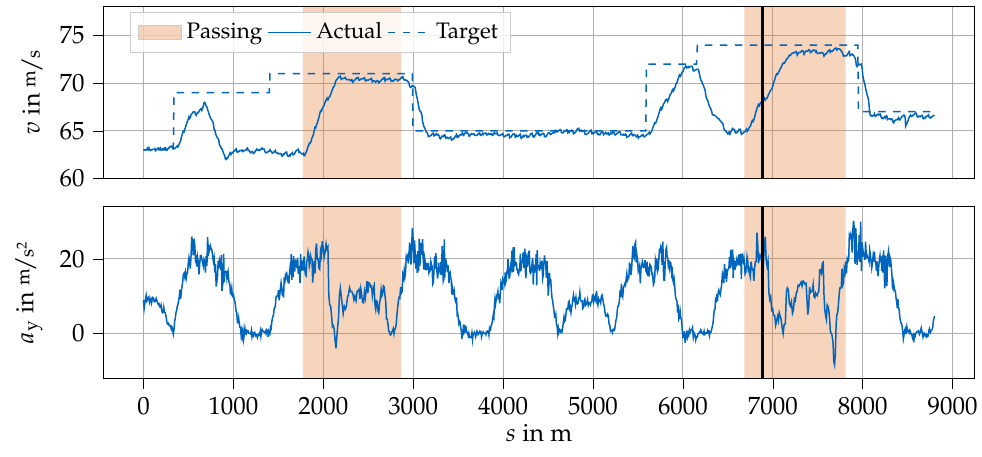
Figure 11. Last two overtaking maneuvers during the final of AC@CES on the LVMS. The permitted passing period is marked in red. The black vertical line indicates the time step shown in Figure